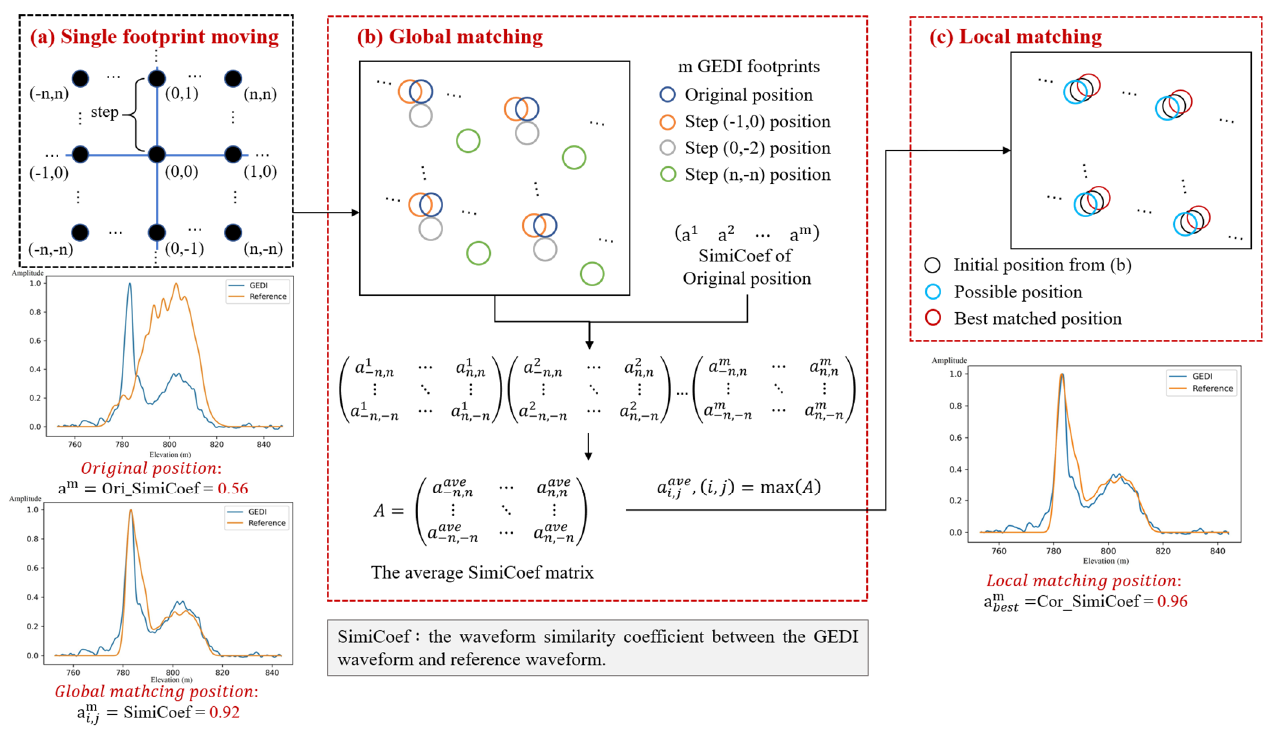
Figure 3. The explanation of the process of calculating the best-matched position of GEDI footprints. Ori_SimiCoef and Cor_ SimiCoef present the SimiCoef of original and best-matched positions.